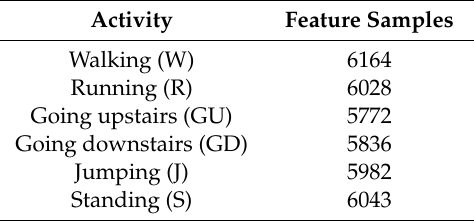
Table 1. Same acquisition feature samples of di ff erent activities from the five body